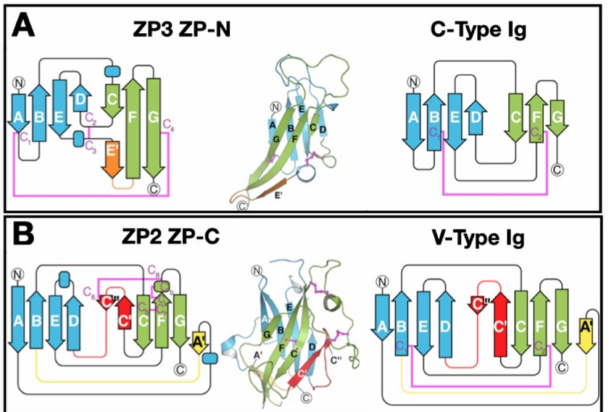
Figure 4. Three-dimensional structures of ZPD subdomains ZP-N and ZP-C that are related to C- and V-type Ig-like domains. ( A ) ZP3 subdomain ZP-N and C-type Ig-like domains. β -strands are labeled using Ig terminology; helices are indicated by rectangles. Opposing β -sheets 1 and 2 are blue and green, respectively, with termini circled. The E (cid:48) strand is orange and disulfides magenta. ( B ) ZP2 ZP-C and V-type Ig-like domains. As in panel A, except for the additional A (cid:48) and C (cid:48) /C” strands that are yellow and red, respectively. This figure was adapted with permission from L. Jovine ([11], Figure 4), Copyright